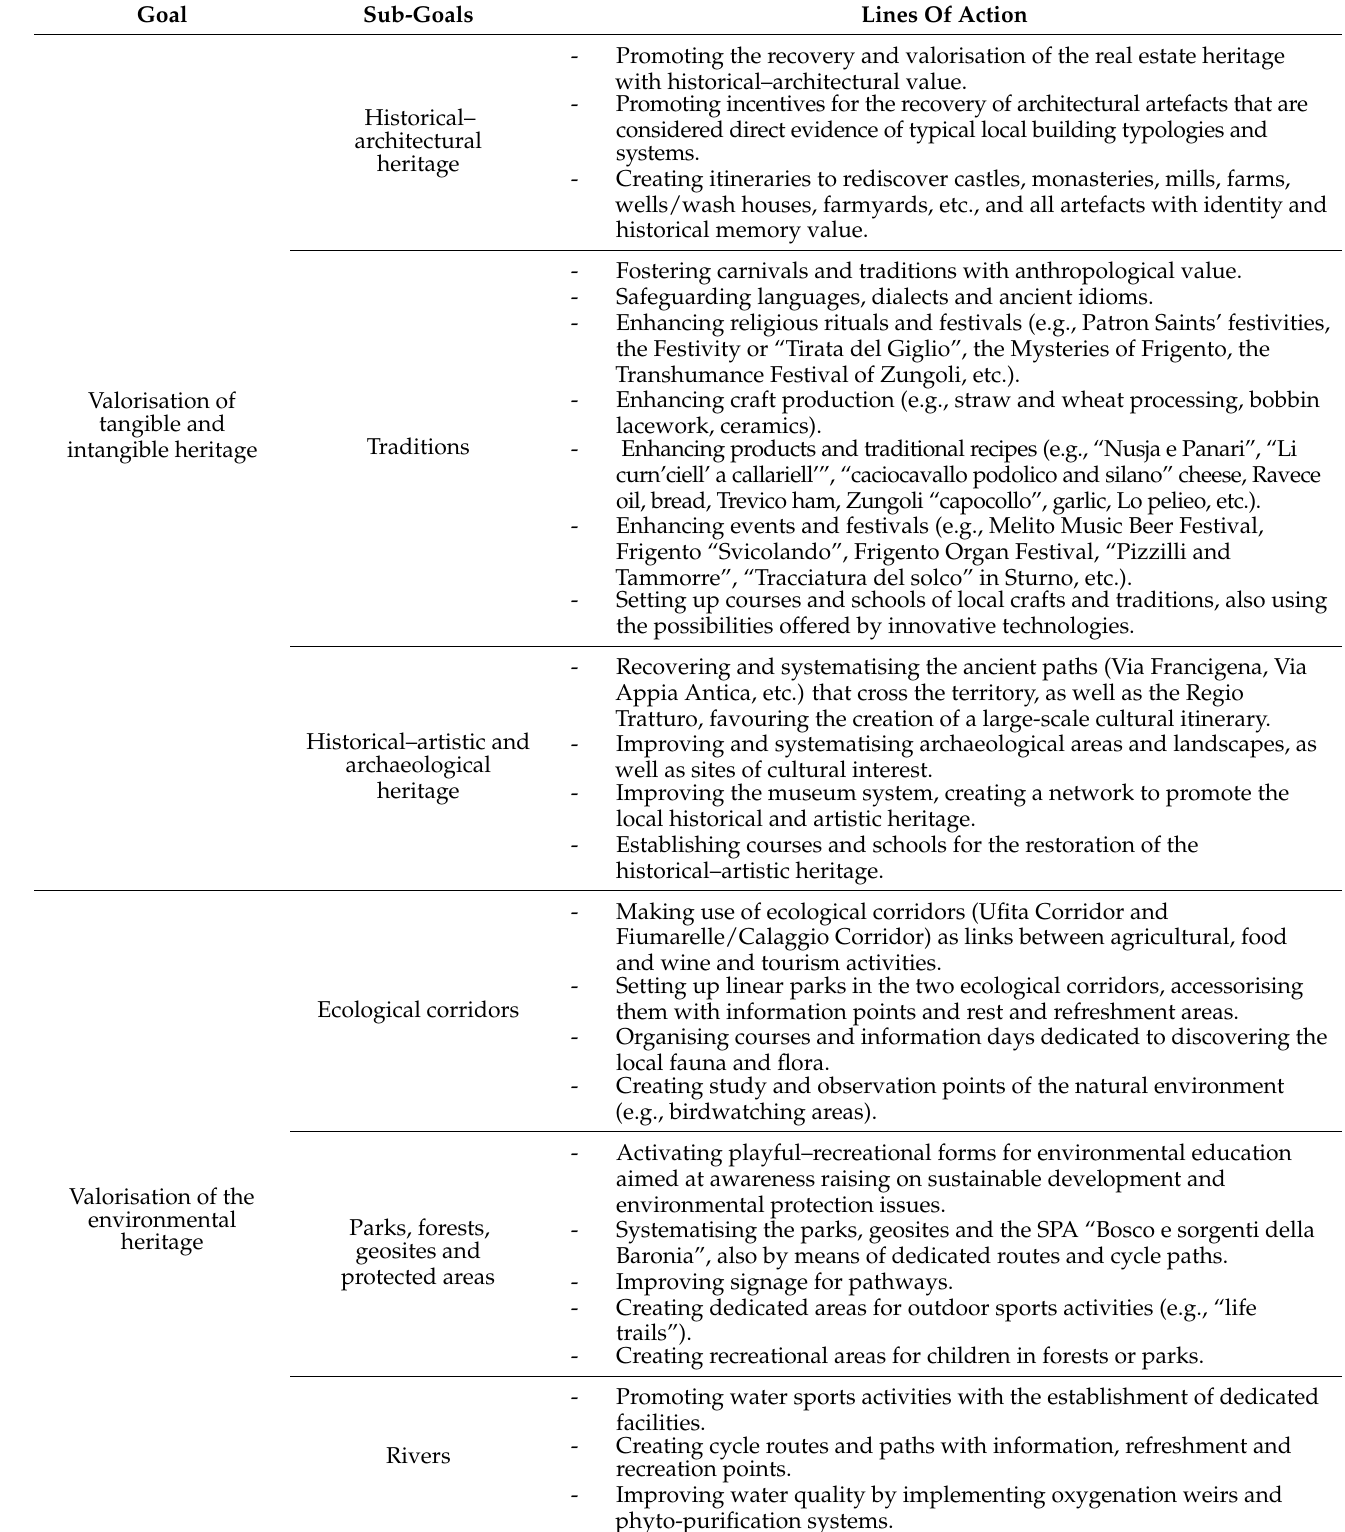
Table A3. Declination of the sub-goals for the “Historical, cultural and environmental heritage” strategic axis into lines of